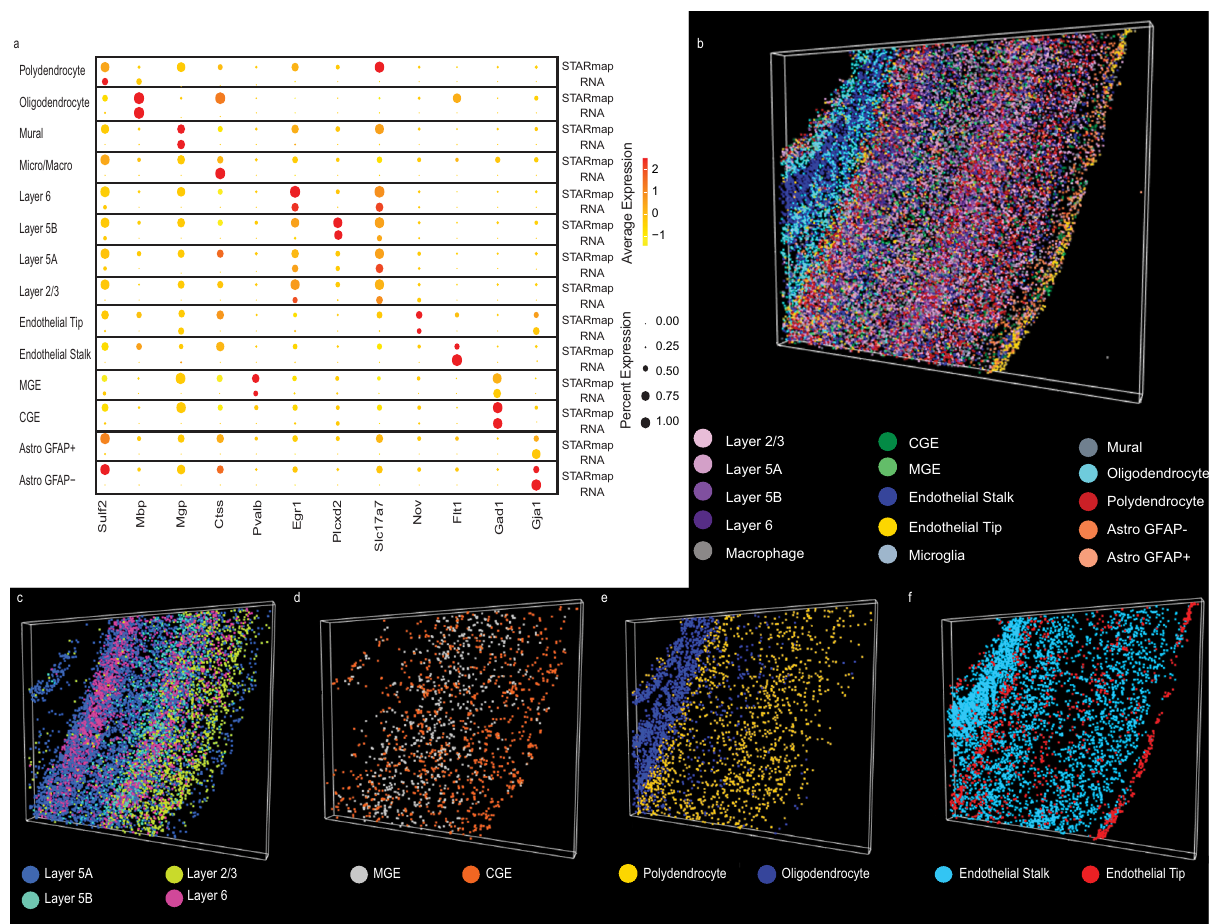
Fig. 4 Incorporating additional genes locates fi ne cellular subtypes within 3D spatial volume. a Dot plot showing marker gene expression in STARmap and scRNA datasets for each joint cluster. The datasets have similar marker expression, indicating that they are well aligned. Plots of three-dimensional spatial locations for different classes of cells colored by cell type: ( b ) all cell types; ( c ) excitatory neurons; ( d ) inhibitory neurons; ( e ) polydendrocytes and oligodendrocytes; and ( f ) endothelial